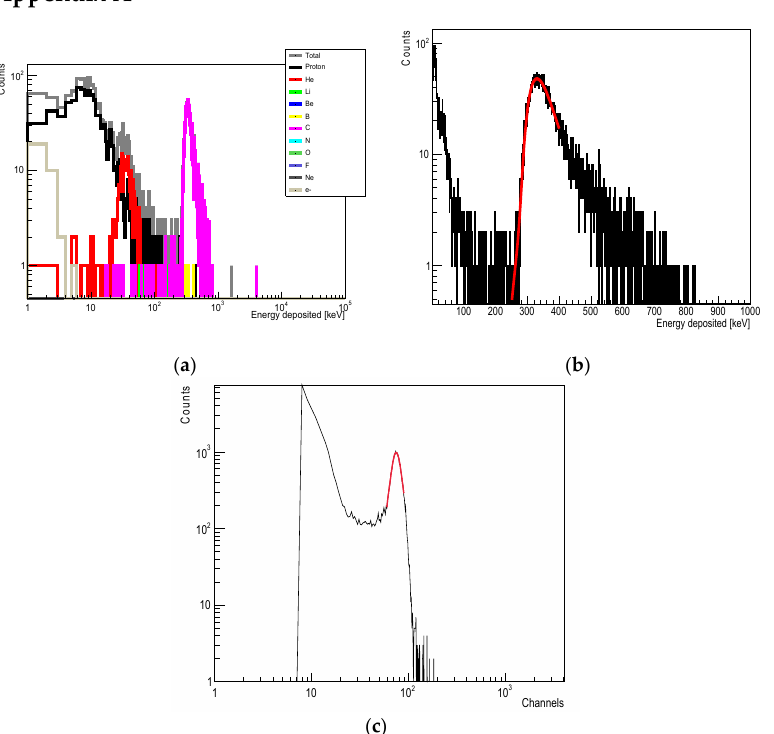
Figure A1. ( a ) Geant4-simulated spectrum of energy deposition in a silicon cylinder 18 µ m in diameter and 10 µ m thick located behind 10 mm PMMA and irradiated with a 170.5 MeV/u 12 C-ion beam (contribution from a direct C ion beam and from fragments with mass atomic number 1 to 10 are colour coded). ( b ) Gaussian fitting (red line) of the carbon peak in a spectrum in ( a ). ( c ) Energy-deposited spectrum from a 12 C-ion beam of the same energy measured by the SOI MicroPlus-mushroom microdosimeter with low gain settings when located behind 10 mm PMMA (Gaussian fitting (red line) of the carbon portion is